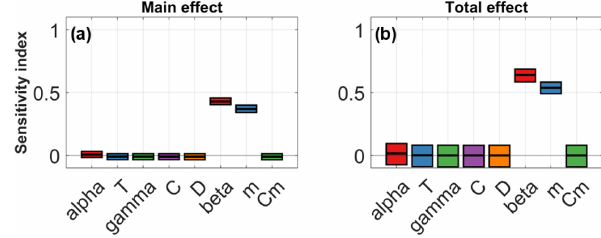
Figure 7. Main effect (a) and total effect (b) sensitivity indices cal- culated using the VBSA method for Vicksburg gauging station. The boxes represent the 25th and 75th percentiles, and the central black lines indicate the